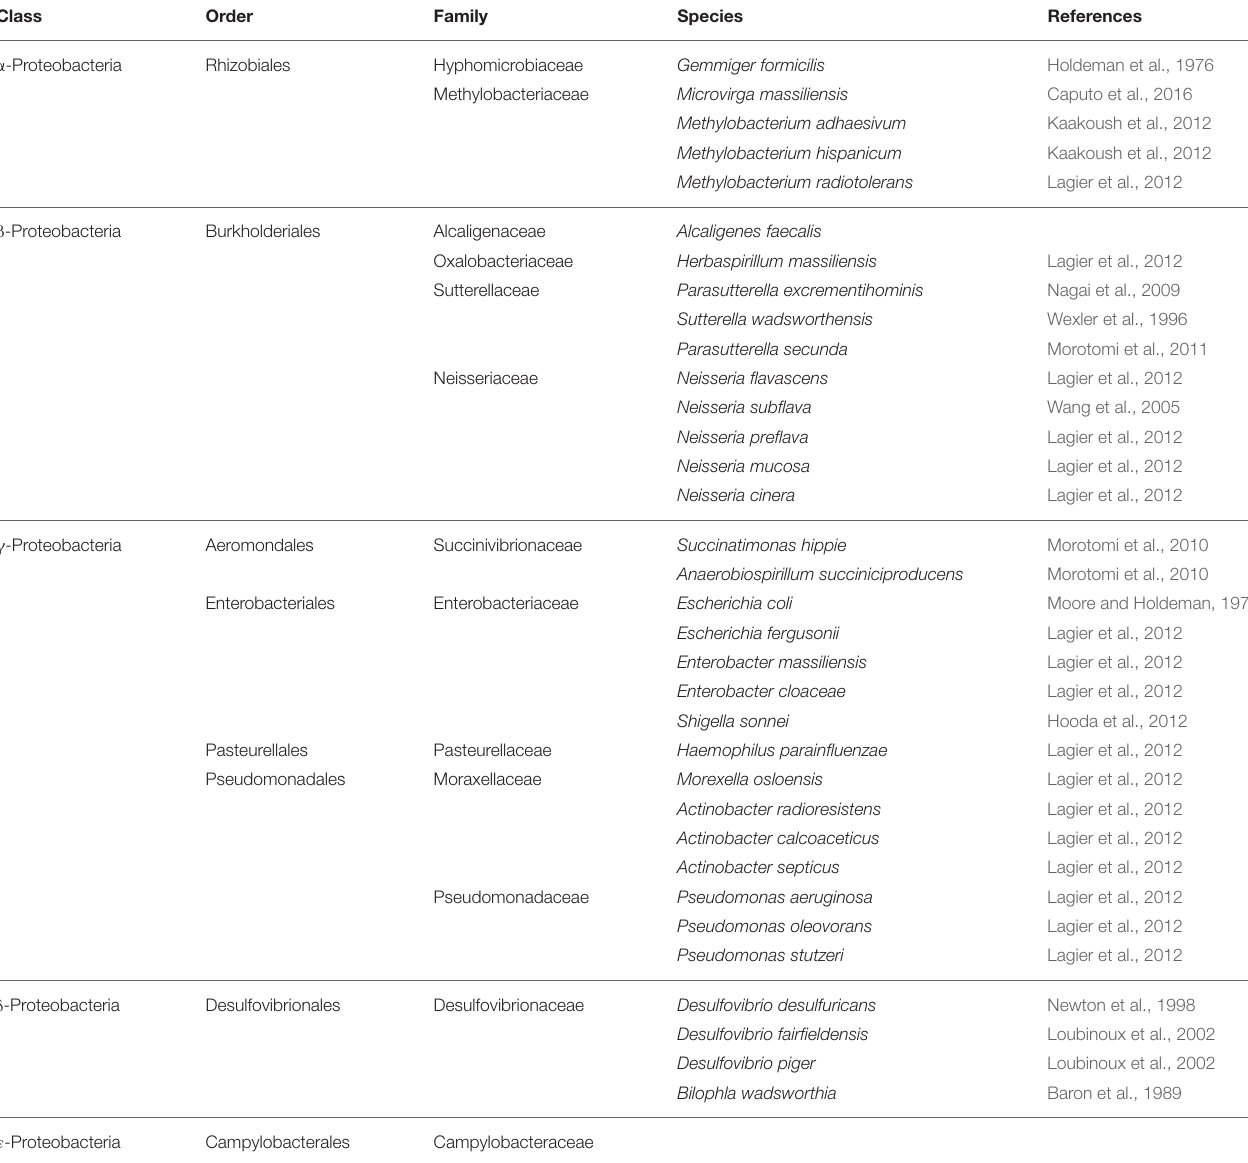
TABLE 2 | Proteobacteria phylum (class, order, family) and major species constituting the microbiota in healthy human